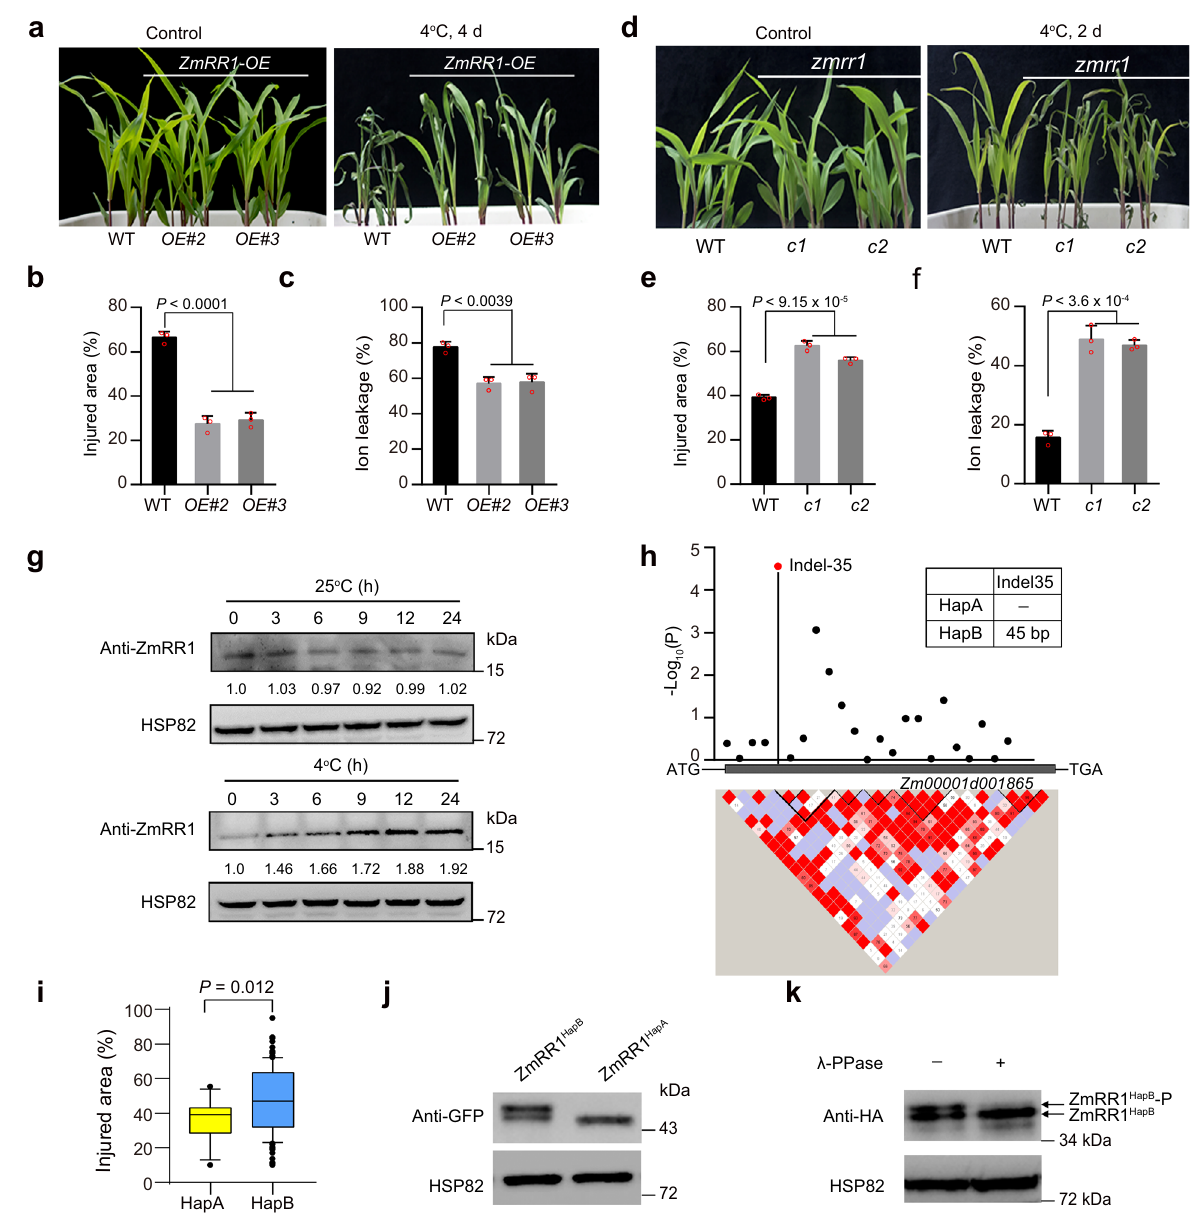
Fig. 1 Natural variation in the ZmRR1 coding region confers chilling tolerance in maize. a – c Chilling phenotypes ( a ), injured area ( b ), and ion leakage ( c ) of ZmRR1 -overexpressing transgenic plants ( OE#2 , OE#3 ) after cold treatment. 14-day-old seedlings grown at 25 °C were incubated at 4 °C for 4 d. Representative images were taken after 2 days of recovery. d – f Chilling phenotypes ( d ), injured area ( e ), and ion leakage ( f ) of zmrr1 mutants ( c1 and c2 ) under cold conditions. g Cold induces ZmRR1 protein accumulation. Ten-day-old WT seedlings were incubated at 25 °C or 4 °C for the indicated times. ZmRR1 was detected with anti-ZmRR1 antibody. HSP82 was used as a control. h ZmRR1-based association mapping and pairwise LD analysis. Indel-35 ( P = 2.75 × 10 − 5 ) is highlighted by a red triangle. Blackdots represent nonsynonymous variants in the coding region of ZmRR1 . Haplotypes of ZmRR1 were grouped according to the signi fi cant variant (Indel-35). i Boxplot showing the injured area of each haplotype. The box shows the median, and the lower and upper quartiles, and the dots denote outliers. ( n = 15 for HapA, n = 146 for HapB). Statistical signi fi cance was determined by a two-sided t -test. j Immunoblot analysis of ZmRR1 proteins in maize protoplasts expressing ZmRR1 HapA -GFP and ZmRR1 HapB -GFP. ZmRR1 was detected with anti-GFP antibody. HSP82 was used as a control. k Immunoblot analysis of ZmRR1 proteins in maize protoplasts expressing HF-ZmRR1 HapB with or without λ - phosphatase treatment. ZmRR1 was detected with anti-HA antibody. HSP82 was used as a control. In b , c , e , f , each bar represents the mean ± SD of three independent experiments. The statistical signi fi cance was determined by a two-sided t -test. In g , j , k , a representative experiment from three independent experiments is shown. Source data underlying Fig. 1b, c, e-g, and i-k are provided as a Source Data fi